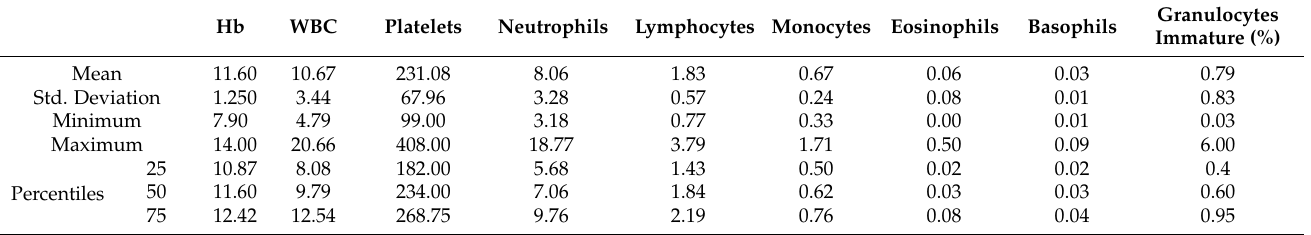
Table 2. Maternal blood cell